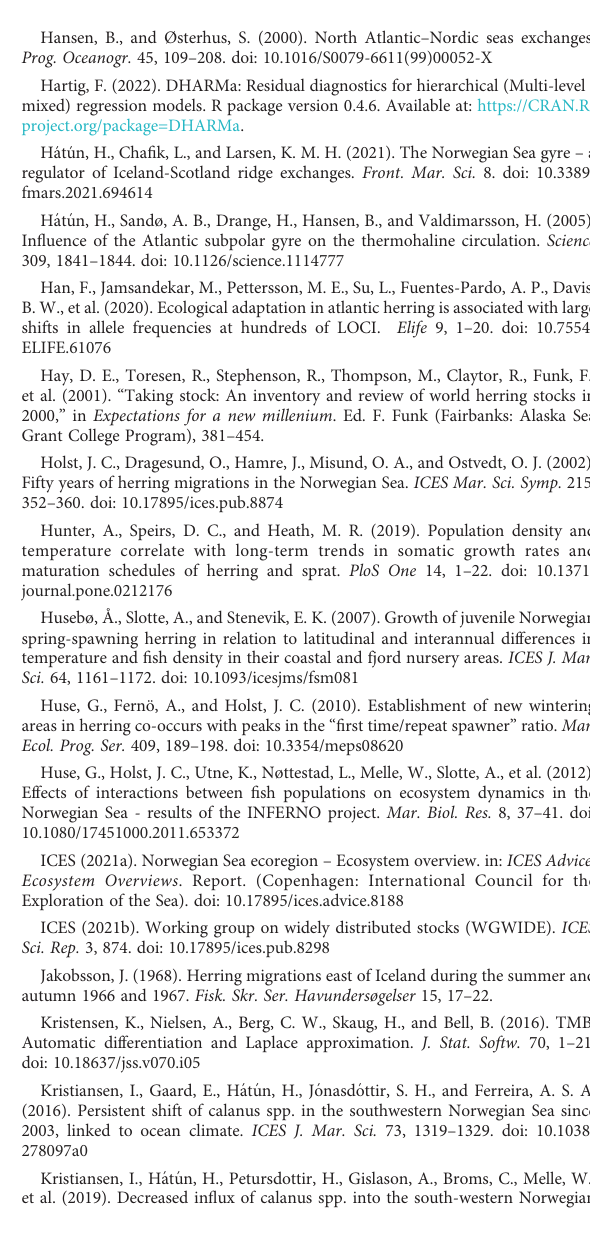
SUPPLEMENTARY FIGURE 10 Modelled spatiotemporal changes in centre of gravity (CG) of gonad development for all ages 3-10+ (vertically) and season (horizontally). The variations in CG are shown split between two groups of herring having body length, fi sh weight and gonad weight either above (red) or below (blue)